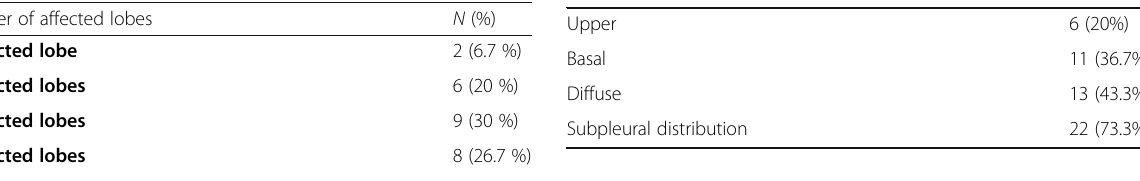
Table 2 The number of the affected lobes with total severity